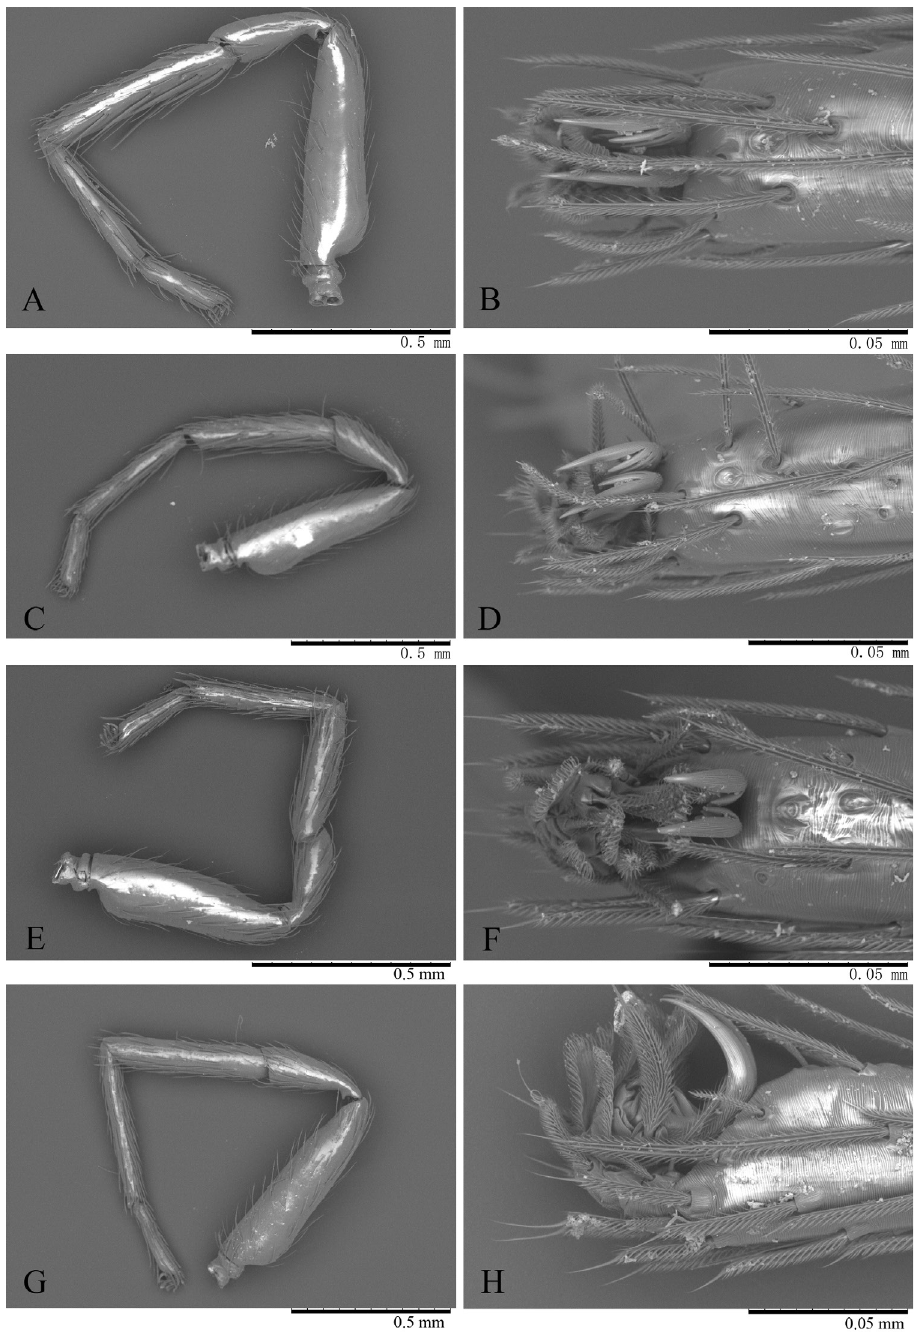
Figure 9. Trilacuna songyuae sp. n., female, right legs, SEM. A leg I, prolateral view B tarsus I, dorsal view C leg II, prolateral view D tarsus II, dorsal view E leg III, prolateral view F tarsus III, dorsal view G leg IV, prolateral view H tarsus IV, prolateral